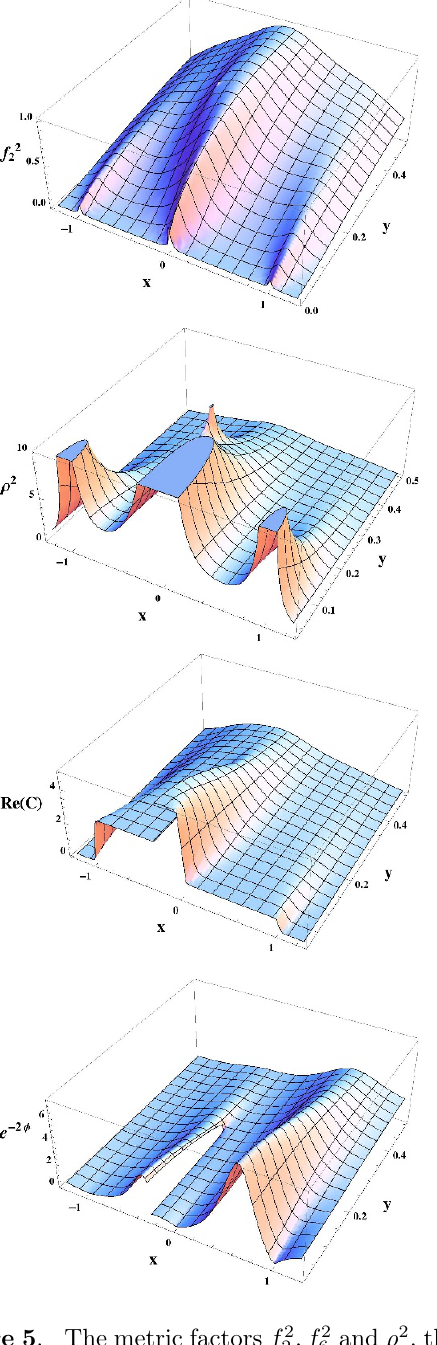
on the boundary as well: since there is no pole or branch cut at in(cid:12)nity, the boundary value of Re ( C ) to the left of all poles equals its boundary value to the right of all poles, but the non-conservation is manifest in the discontinuity at the point where the branch cut intersects the real line. Axion and dilaton now both behave non-trivially when crossing